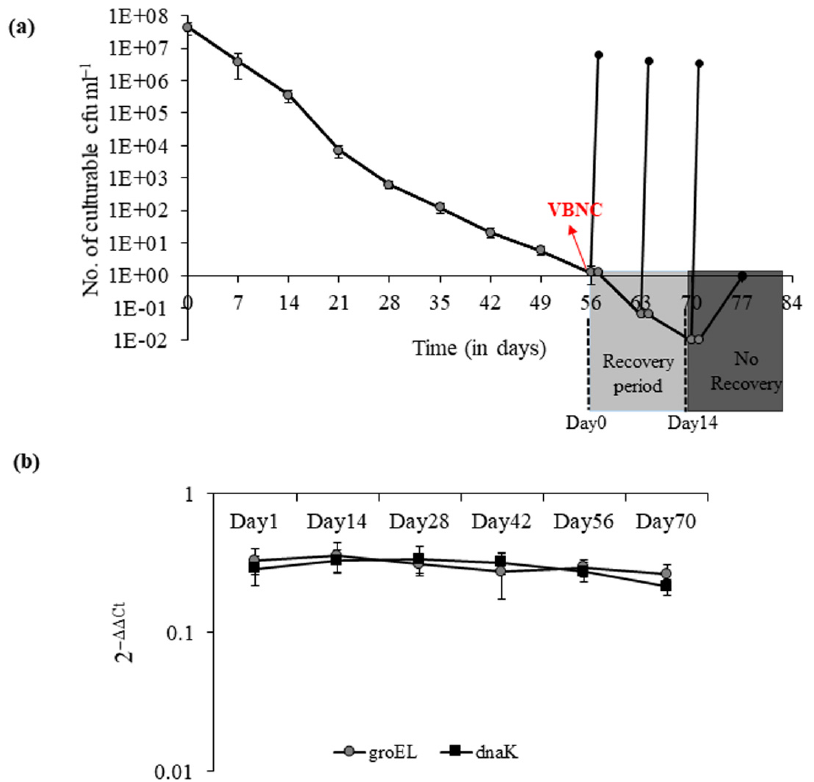
Figure 1. Progress curve of V. cholerae culturability and viability during the course of VBNC induc- tion.( a ) Culturable cell count was determined for V. cholerae AN59 during the induction of VBNC state at 4 ° C ( ● ) in ASW. Recovery was induced on days 56, 63, 70 and 77 after entry into VBNC state by temperature upshift from 4 ° C to 37 ° C ( ● ). Each bar represents the mean ± SE of three independent experiments. ( b ) The relative mRNA expression of transcripts of molecular chaperones ( ■ ) dnaK and ( ● ) GroEL were analyzed during the course of VBNC induction as an in- dicator of cell viability.